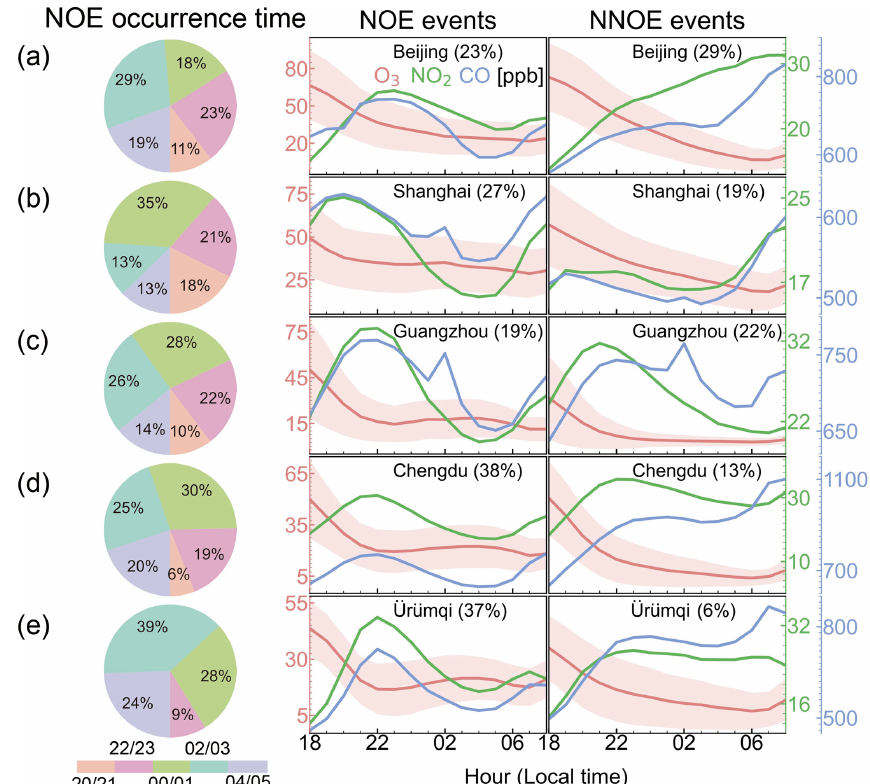
Figure 4. Comparison of the temporal variation in nocturnal air pollutants (ozone, NO 2 , and CO) between the NOE and the NNOE events in the warm season in five typical cities (Beijing, Shanghai, Guangzhou, Chengdu, and Ürümqi). Each city contains a number of monitoring sites, and we average the data across the sites within the city to represent ozone at the city level. The numbers in parentheses represent the frequency of NOE and NNOE events in the city. The estimated NOE frequency at the city level based on the site-average ozone values is lower than that at the site level, as the occurrence time of NOE events may vary at different sites. Note that the axis range for different cities varies. The pie charts show the frequency of the occurrence time of the NOE events, defined as the time with maximum ( (cid:49) O 3 /(cid:49)t ) in each NOE event.